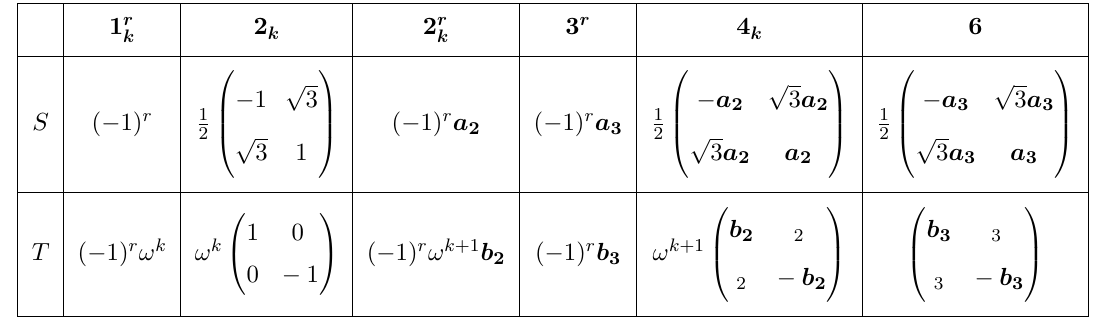
Table 5 . The representation matrices of the generators S and T for the twenty-one irreducible representations of Γ 0 in the chosen basis, where ω = e 2 πi/ 3 , r = 0 , 1 , k = 0 , 1 , 2 and matrices a 2 , 6 b 2 , a 3 and b 3 are shown in eq.